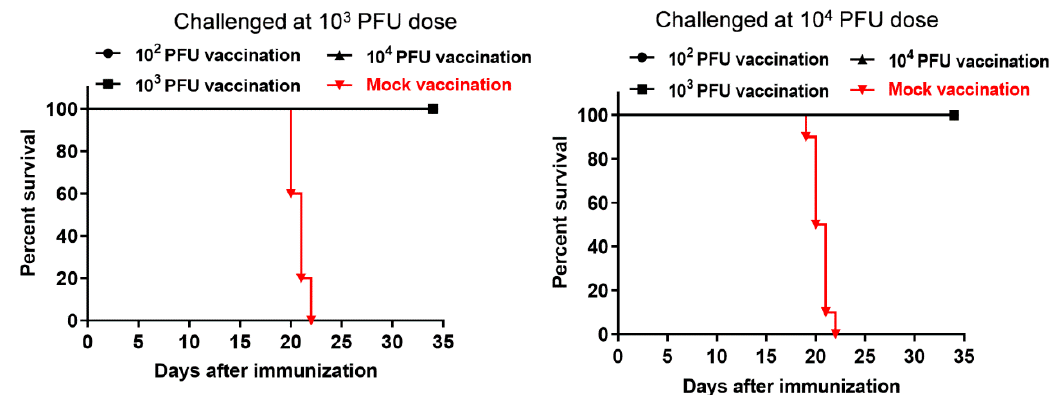
Figure 4. Protective e ffi cacy of SD12-F120 against SD12 challenge in mice. Mice (8 mice / group) were mock-vaccinated or vaccinated intraperitoneally with SD12-F120 at doses ranging from 10 2 to 10 4 PFU. After 14 days of vaccination, the mice were challenged intraperitoneally with SD12 at a dose of 10 3 and 10 4 PFU, respectively, and were monitored daily for 20 days.